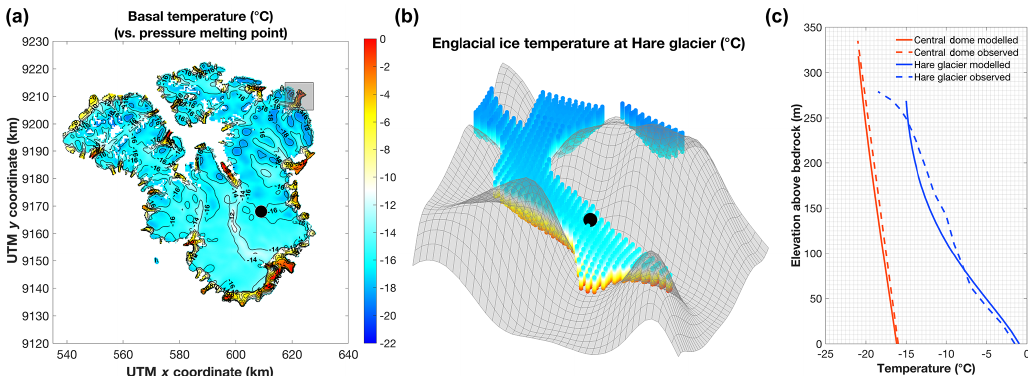
Figure 6. (a) Modelled basal temperatures for the 1961–1990 steady-state ice cap. The shaded grey box represents Hare glacier, the area shown in (b) ; the black dot represents the drill site at the central dome. (b) Englacial temperatures at Hare glacier; the colour scale is the same as in (a) . The black dot represents the location of the drill site where englacial temperatures were measured. (c) Modelled and measured (observed) temperature profiles for the central dome and at Hare